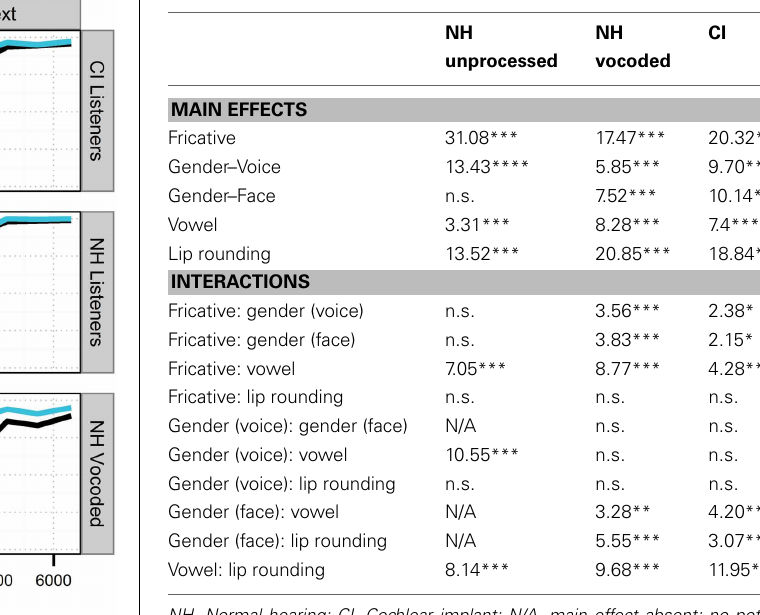
Table 5 | Main effects and interactions in experiment